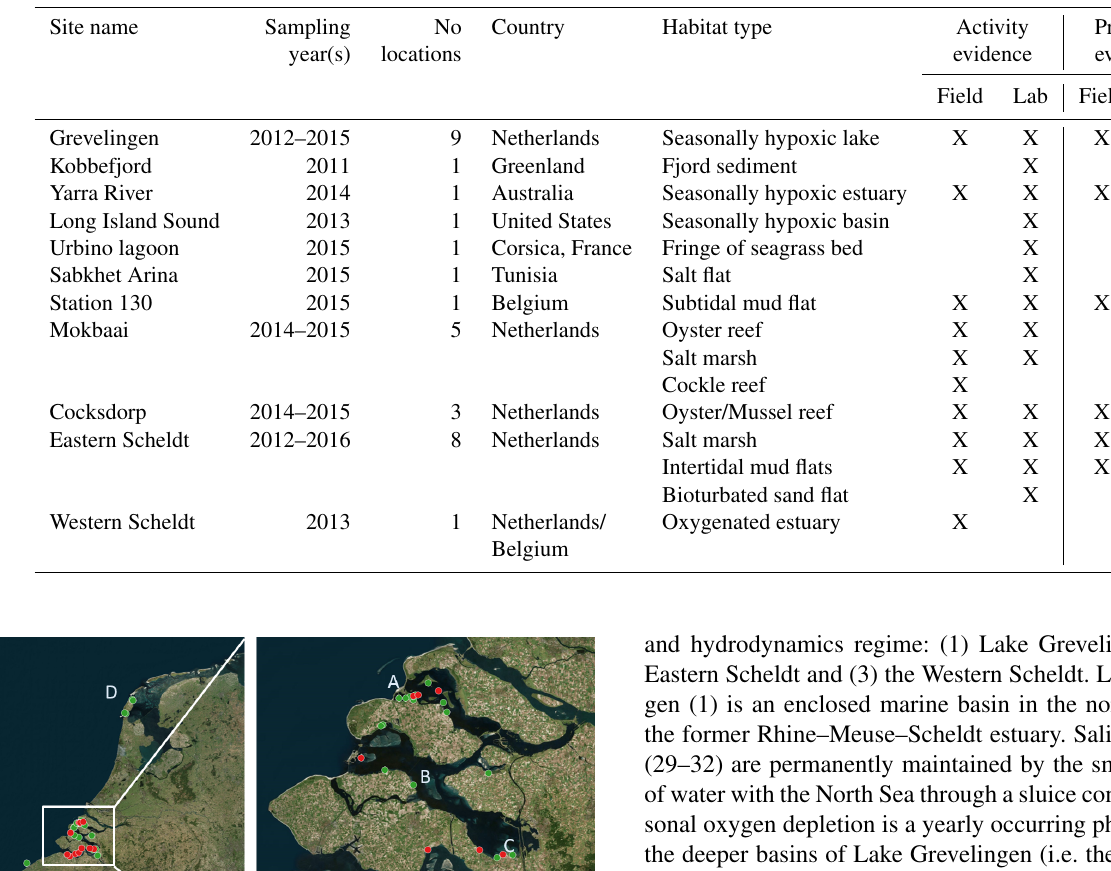
Table 1. Summary of the global sample sites where cable bacteria activity was measured or presence of cable bacteria was demonstrated. Full details of all locations are given in Table S1.